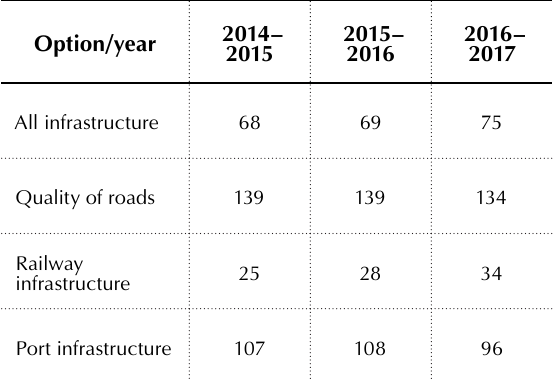
Table 5. Positions of Ukraine in the rating of competitiveness of the world’s countries